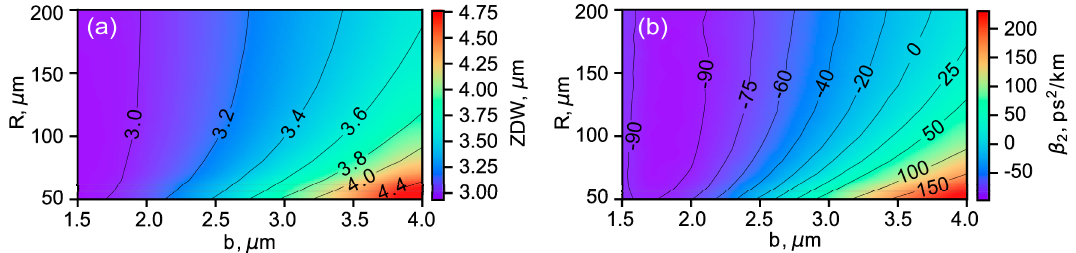
Figure 2. Zero-dispersion wavelength as a function of thickness and radius of a microbubble ( a ). Dispersion as a function of thickness and radius of a microbubble calculated at λ p = 3.5 μ m ( b ).